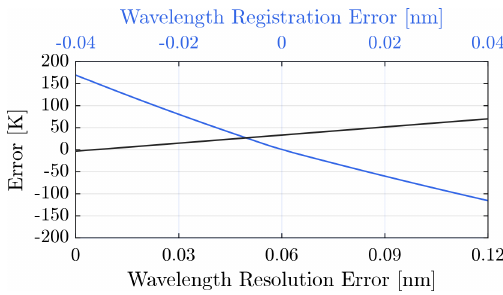
Figure 3. Expected bias errors in T ci as a function of the two dom- inant known sources of systematic measurement errors: the instru- ment’s spectral registration (blue) and variations in the spectral res- olution